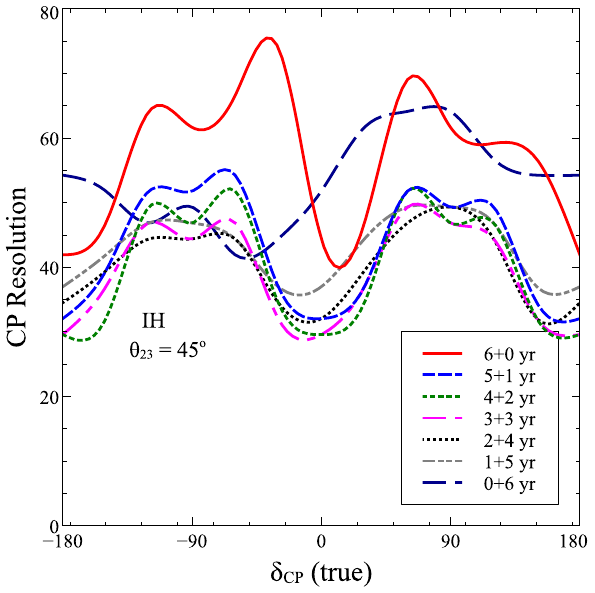
Fig. 12 CP resolution sensitivity in IH as a function of δ CP (true) for θ = 45 ◦ . This is presented for four different neutrino–antineutrino 23 ratios